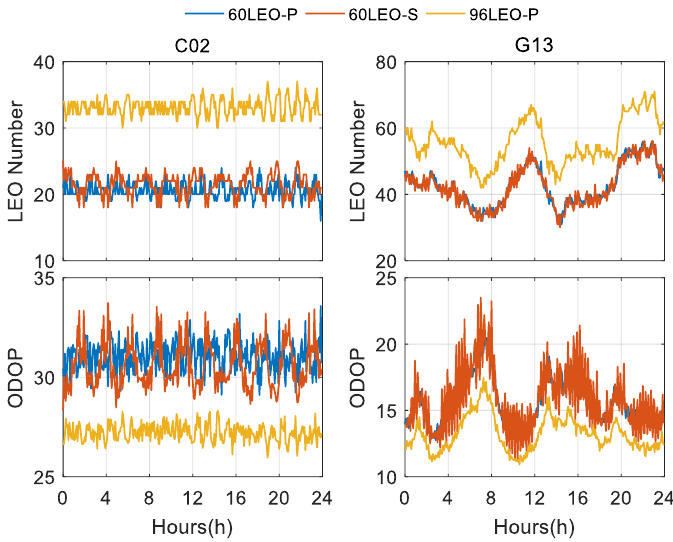
Figure 8. Time series of used LEO satellites number and the ODOP values for BDS GEO C02 (left) and GPS G13 (right).